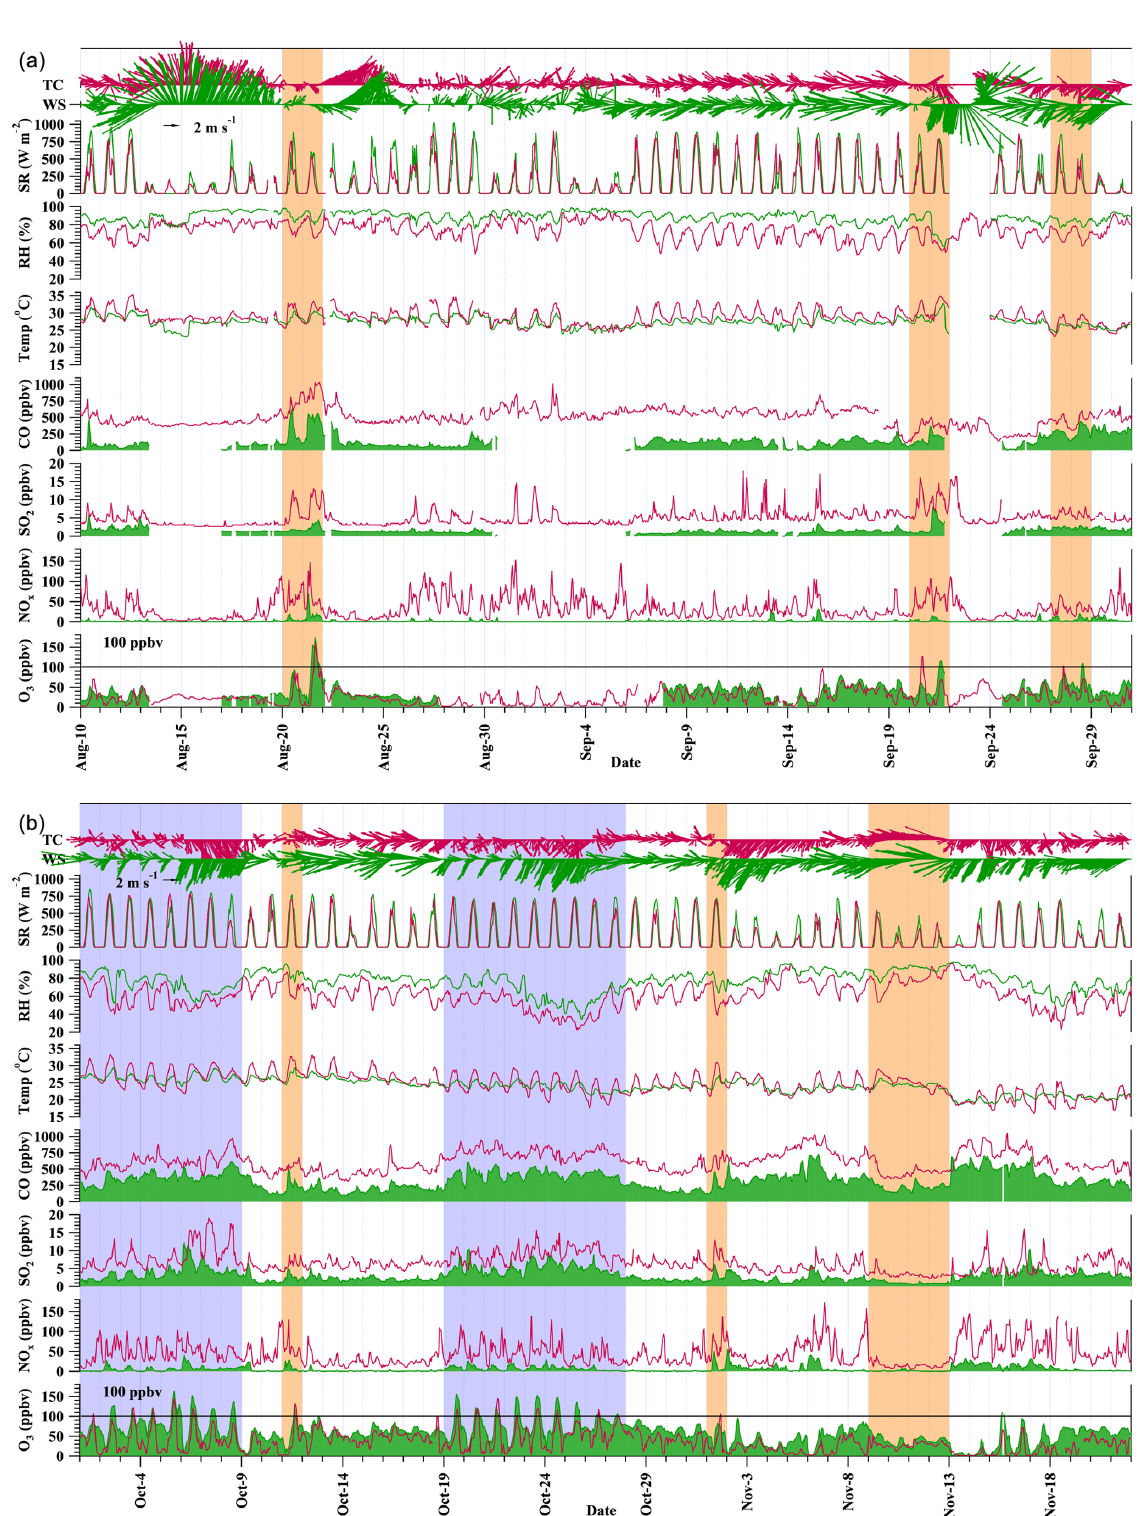
Figure 2. Time series of trace gases and meteorological parameters observed for the sampling period of 10 August–30 September (a) and 1 October–21 November (b) at WS (green) and TC (red). The black line of 100ppbv is the threshold for O 3 episode definition. The dates seriously affected by continental high pressure and tropical cyclones are shaded in blue and orange, respectively. Note that there are some data missing in these months due to extremely bad weather conditions and instrumental